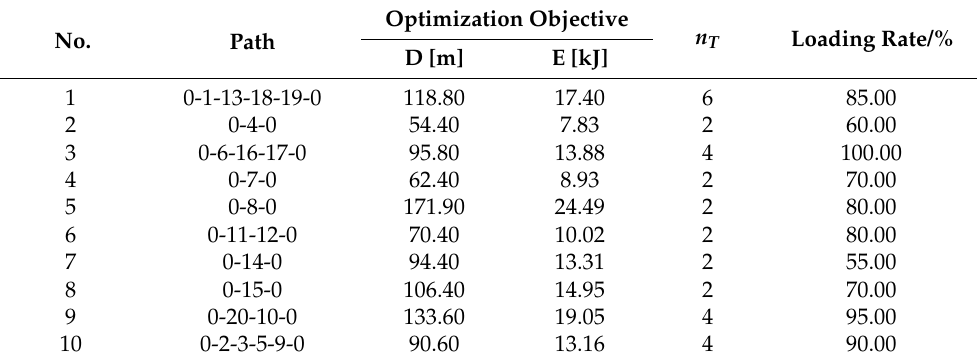
Table 10. Feasible paths for using type 1 AGV fleet